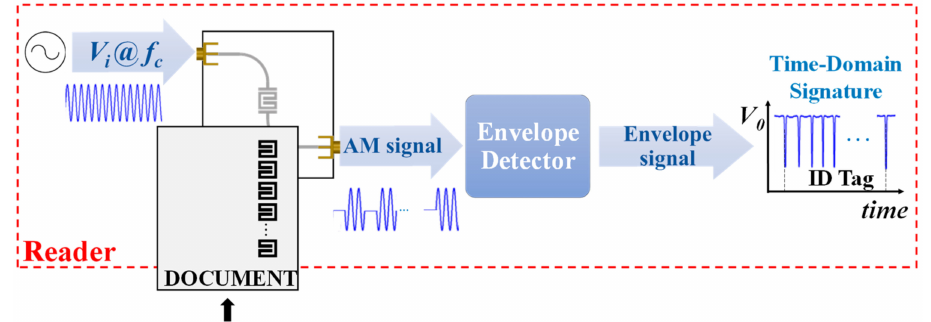
Figure 11. Sketch of the working principle of time domain chipless-RFID systems based on near-field coupling and sequential bit reading.